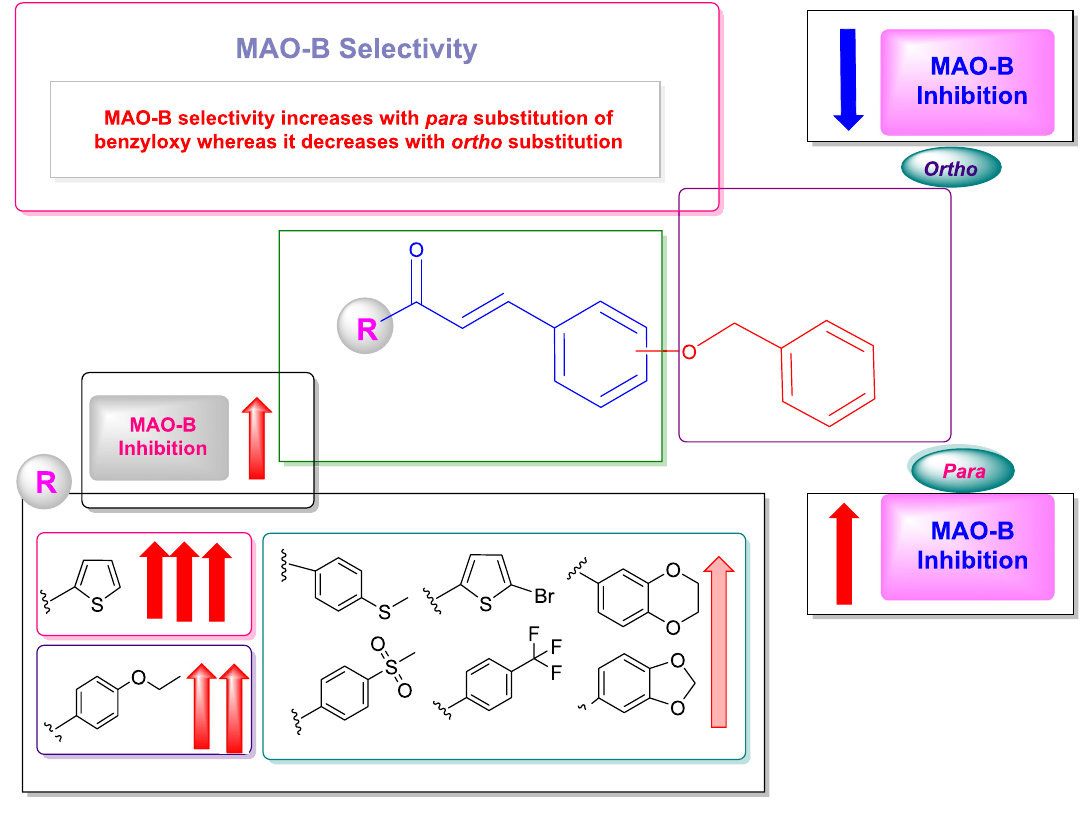
Figure 4. Structure–activity relationships of benzyloxy chalcones.